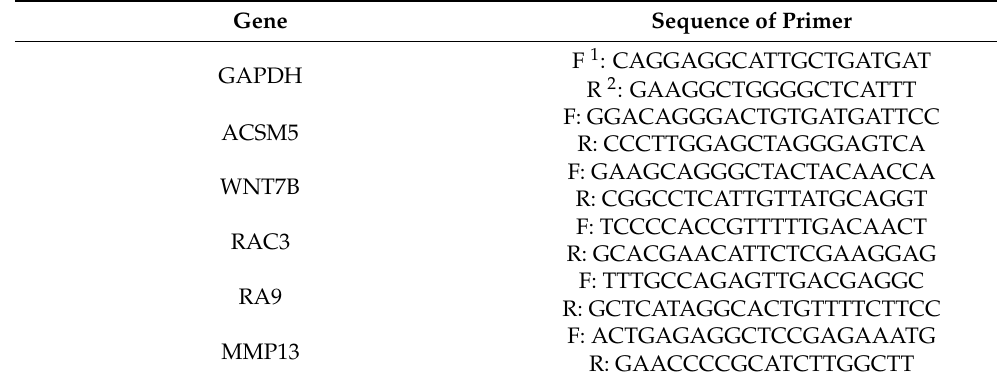
Table 1. Sequences of the primers used in